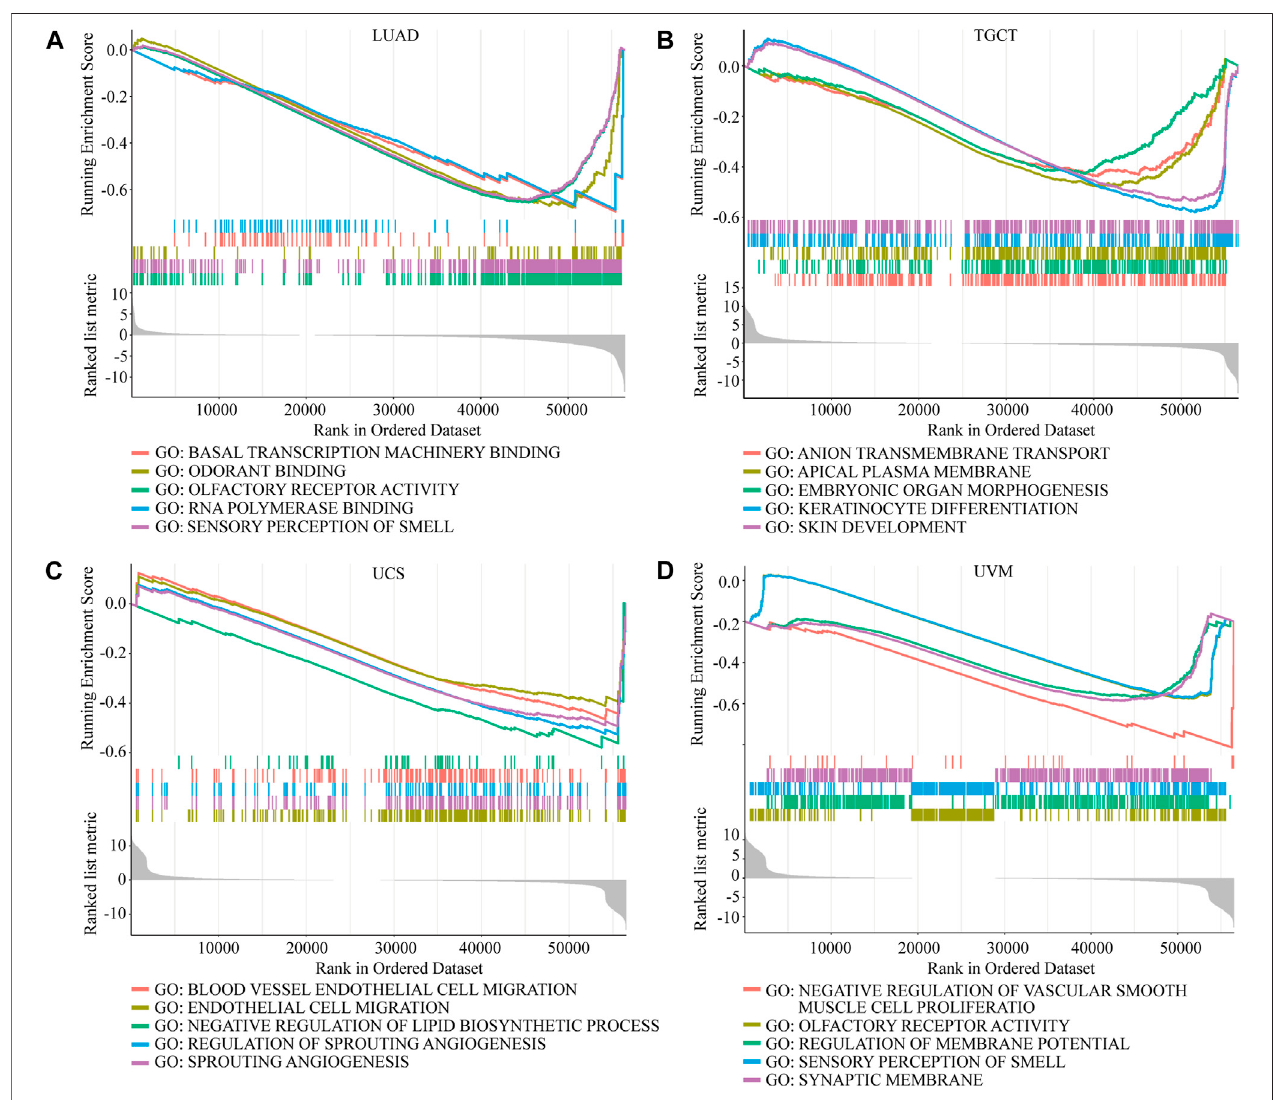
FIGURE 9 | GO enrichment analysis of NOP2 in LUAD, TGCT, UCS, and UVM. Values of p < 0.05 and results higher than fi ve were considered and displayed. (A) LUAD. (B) TGCT. (C) UCS. (D) UVM.